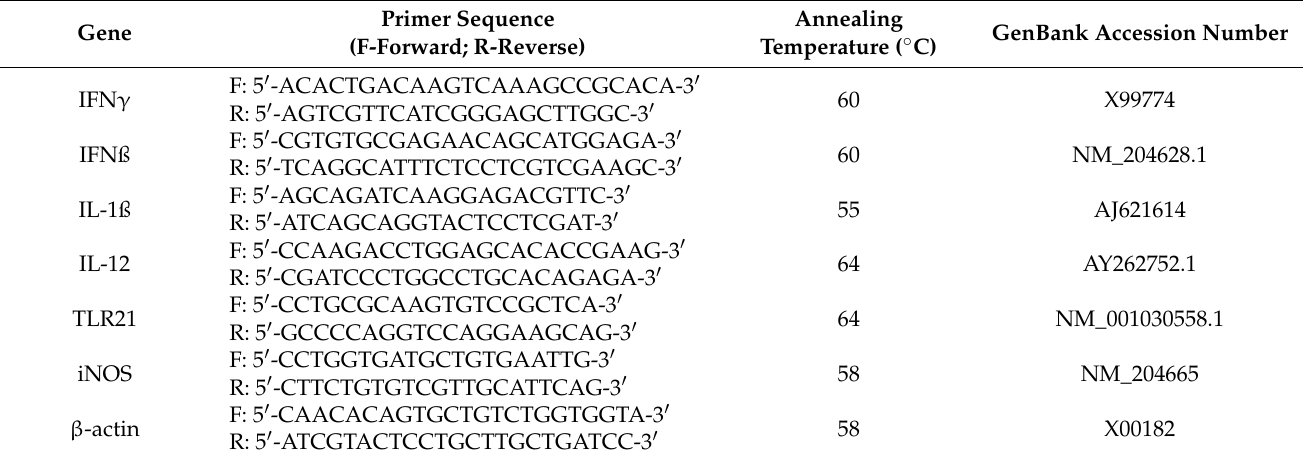
Table 1. Primer sequences used in real-time